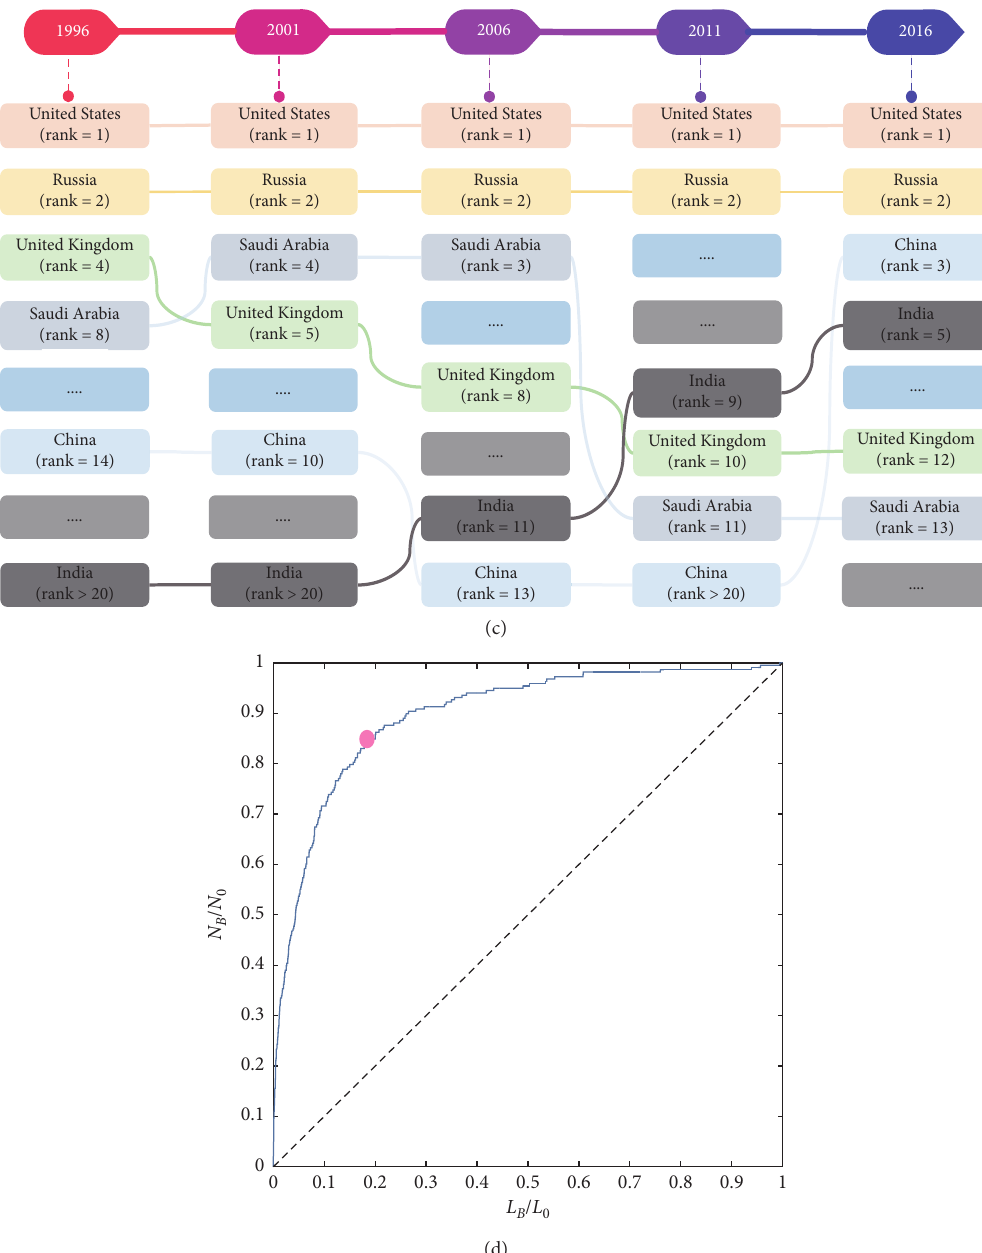
Figure 4: The embedding results of international trade networks. (a, b) The visualization of the international trade network on the Poincar´e disk. To facilitate the display of the position of the nodes, we highlight the origin nodes and end nodes. (a) Origin nodes are highlighted, and yellow nodes on the edge are end nodes so that the popularity and similarity of origin nodes in the disc are visible. (b) The end nodes are highlighted. (c) The ranking evolution over time of the centrality of major countries as measured by the distance from the center of disc. (d) The curve denotes the fraction of nodes N B / N vs. the fraction of links L B / L . N B and L B represent the number of nodes and links in 0 0 backbone networks. The pink dot represents the appropriate threshold in the extracting